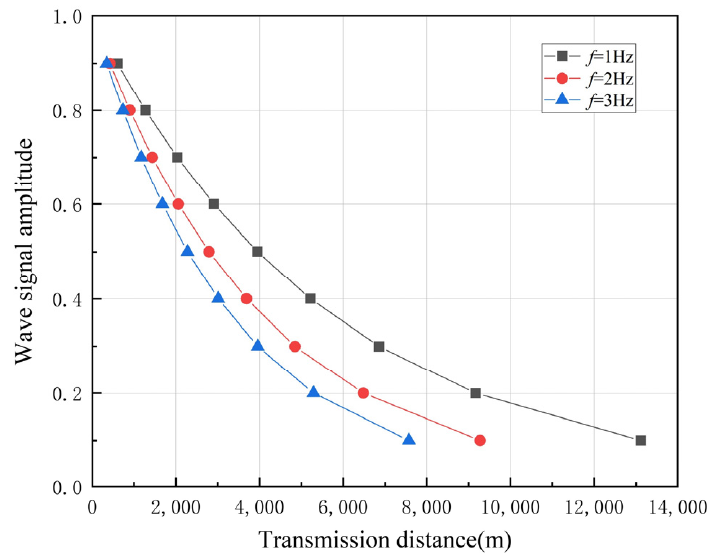
Figure 6. Effect of frequency on wave signal attenuation. Three gas contents of 0.5%, 1.0% and 1.5% were selected for analysis. As shown in Figure 7, the increase in gas content dramatically decreases wave amplitude. The main reason is that when the wave encounters the gas in the dispersed phase, scattering loss is caused by the diffuse reflection at the interface due to the great difference of gas and liquid impedance.